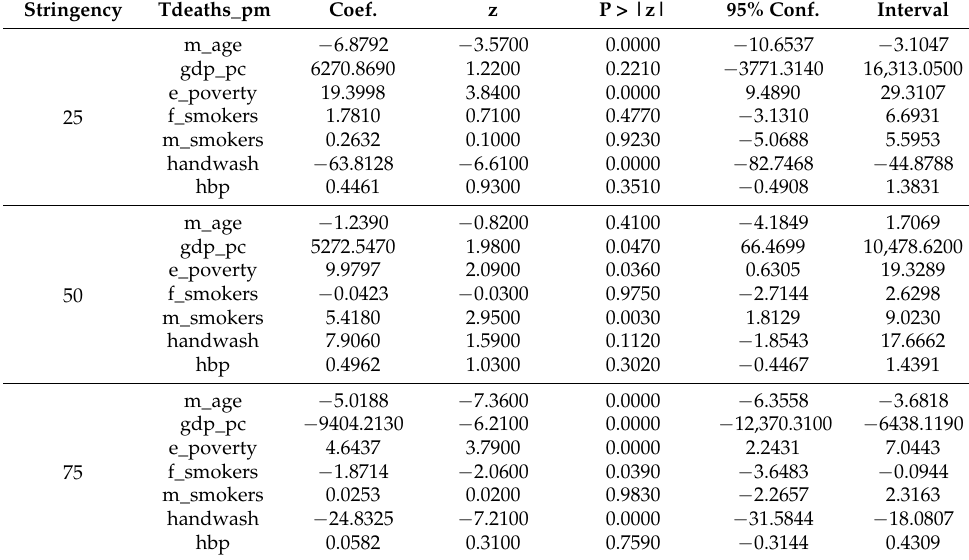
Table 4. Continuity test for control variables in regression discontinuity.